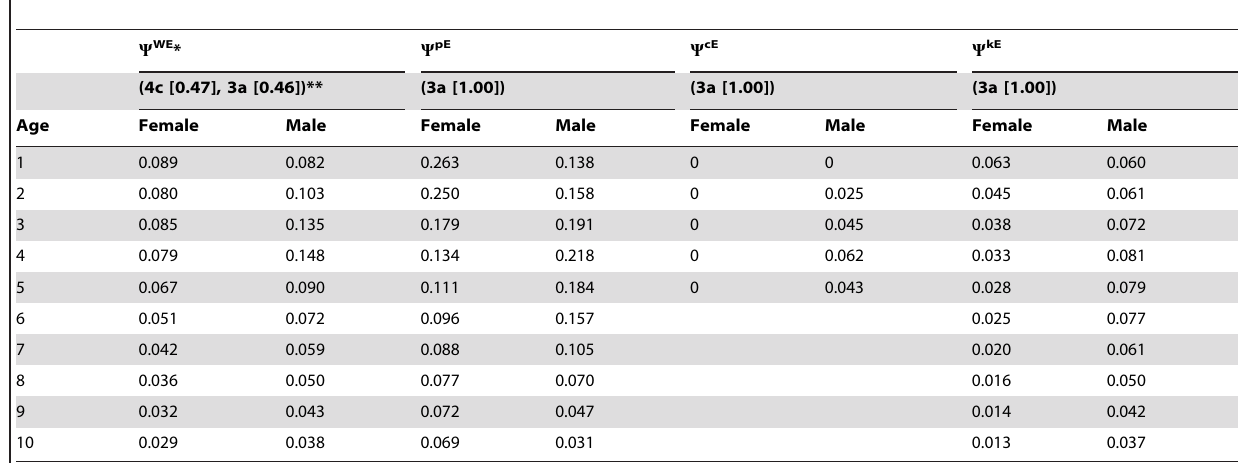
Table 4. Estimated annual age- and sex-specific occupancy probabilities for western DPS Steller sea lions being in their non-natal DPS during the breeding season; the estimates were derived from the best of 9 models for each set of estimates (see Table 2).